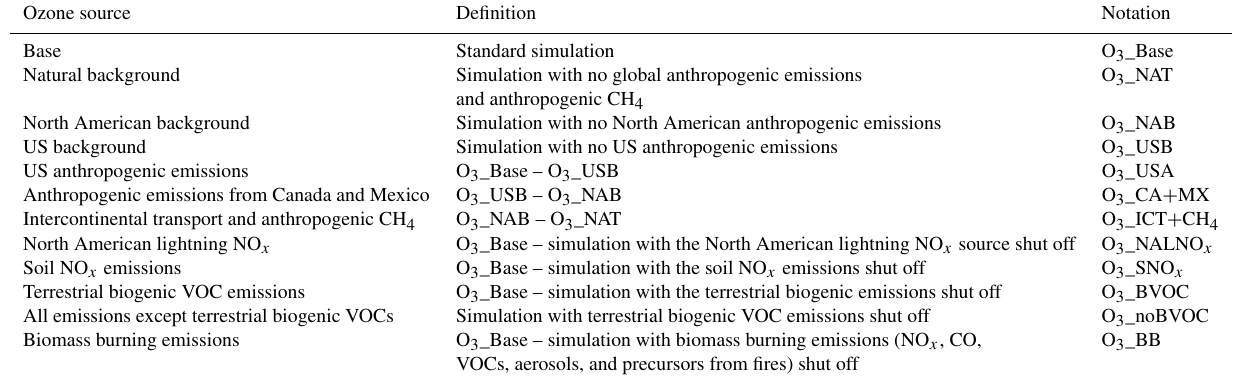
Table 1. Sensitivity simulations with the GEOS-Chem model and their application to estimate sources of ground-level O 3